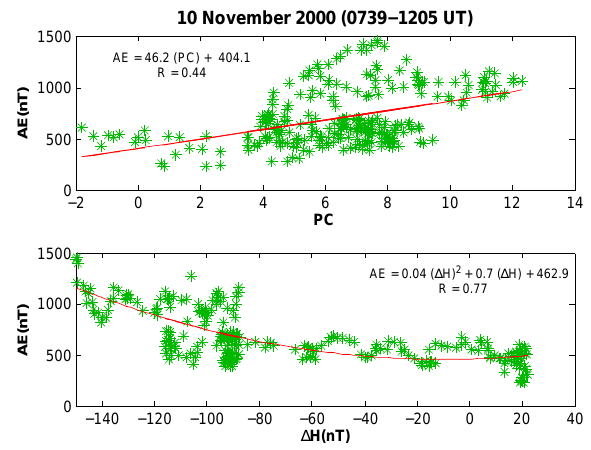
Fig. 15. Correlations between PC and AE (upper panel) and 1H ABG and AE index (lower panel) during “ T 2” period (07:39- 12:05 UT) of the 10 November 2000 storm event.